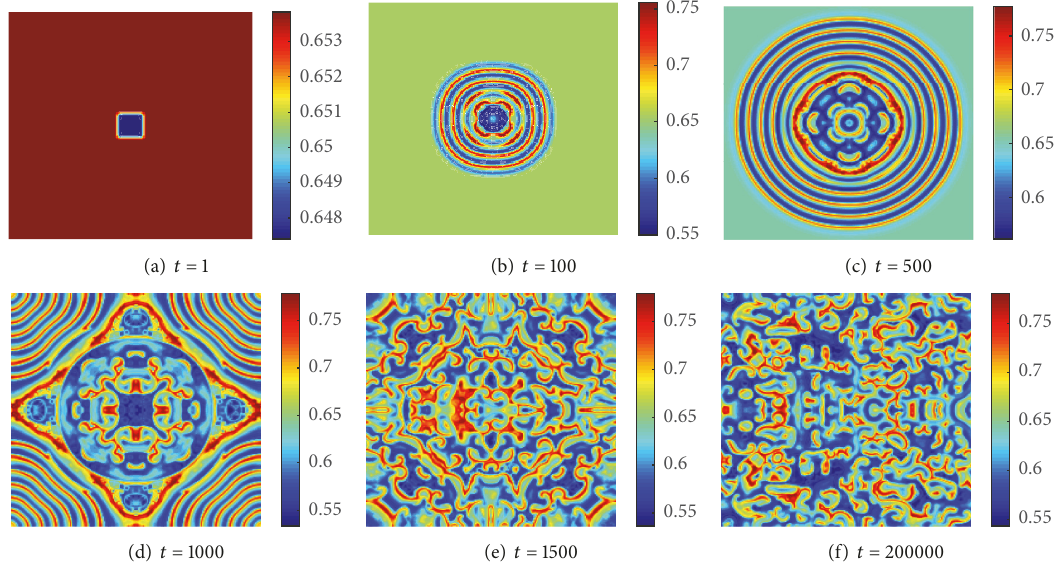
Figure10:Patternformationresultingfromspatiallysymmetrybreakingonchaoticattractorandstartingwithdeterministicinitialcondition. 𝑎 = 1.63, 𝑏 = 0.1, 𝑐 = 0.32, 𝑑 = 0.22, 𝐷 𝐷 𝜏 = 5.83, 𝛿 = 10, and 𝑛 = 200. 1 = 0.6, 2 = 1.2,